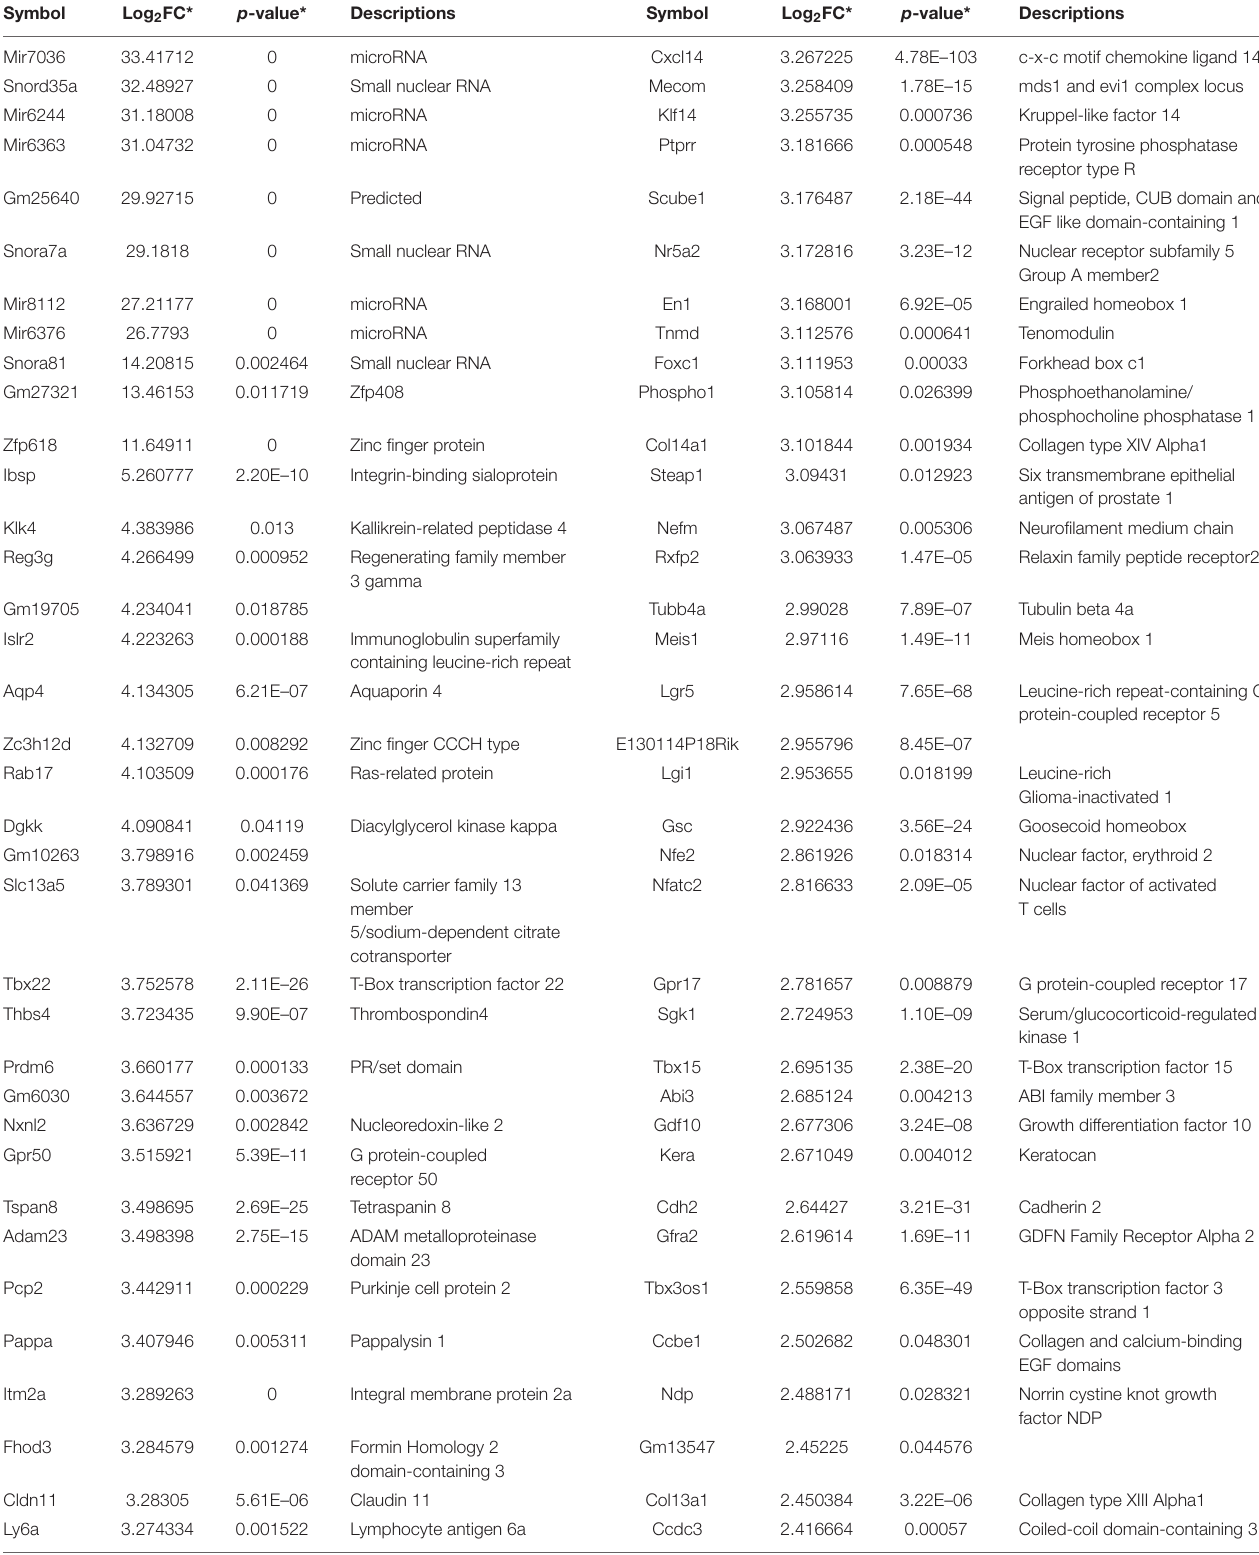
TABLE 2 | The list of genes which show a UD pattern in time series analysis of TS#12.5 with differentially expressed genes (DEGs) of diastema to molar region.